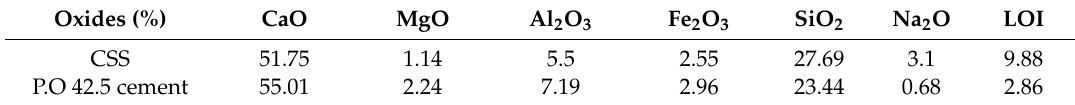
Table 1. Main chemical components of raw